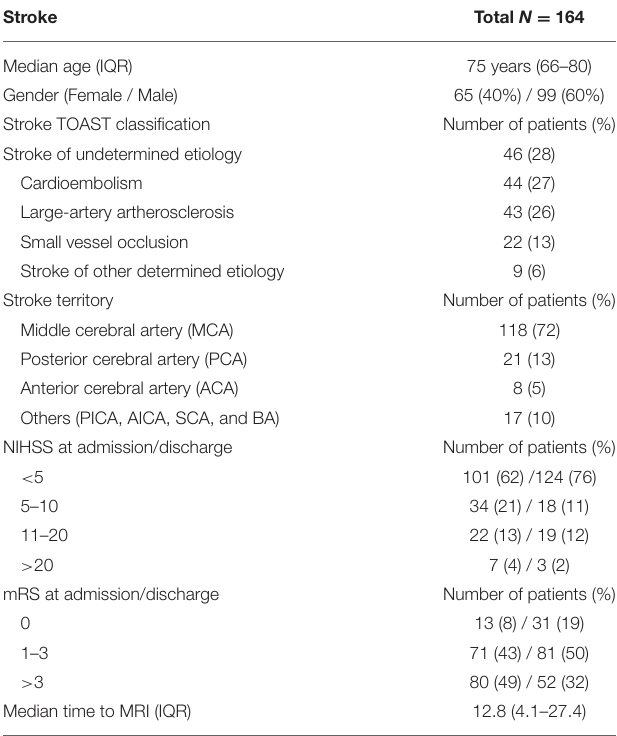
TABLE 2 | Demographic and clinical variables of stroke